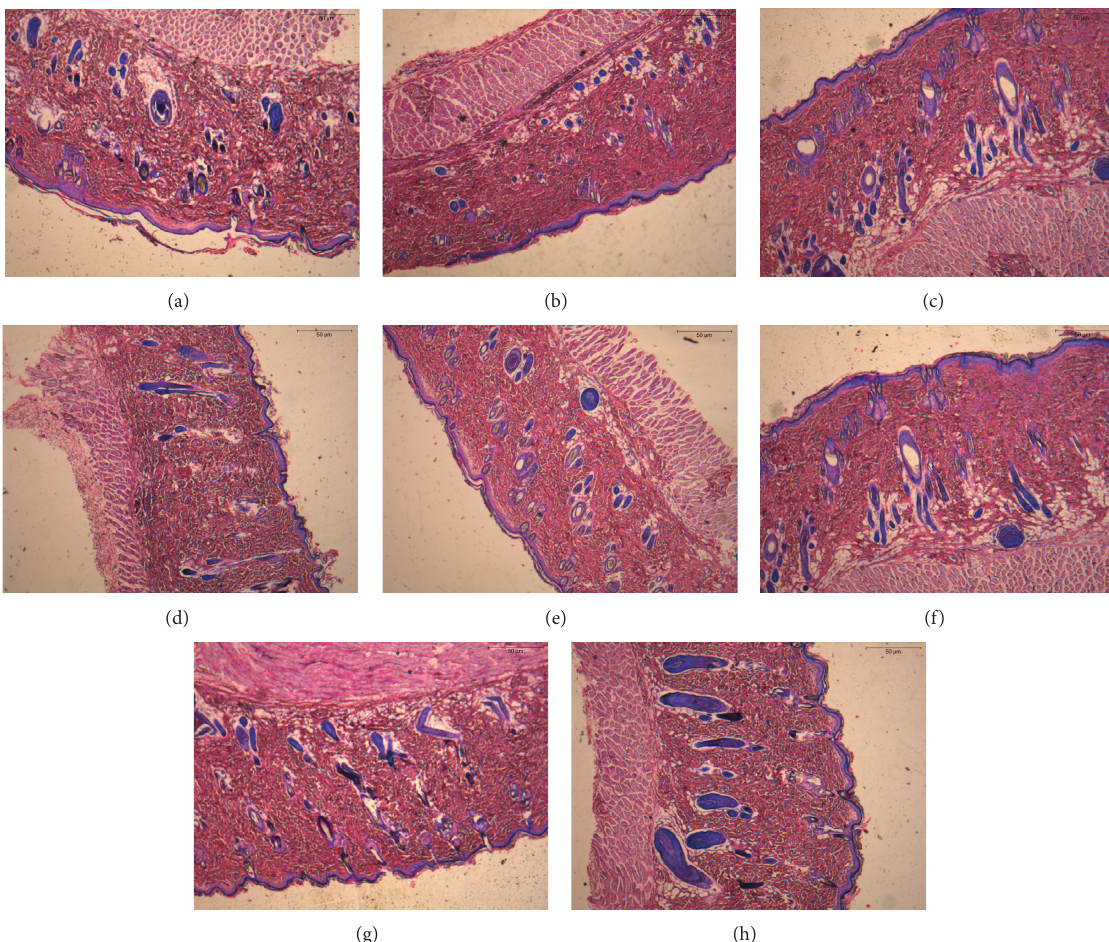
Figure 1: Histological appearance of skin wound from D-gal induced aging model of rats. Skin wounds were harvested for histology at 42 days after each treatment. Representative images of sections stained with H&E were presented at a low magnification (40x, scale bar = 50 𝜇 m). Letters (a) through (h) correspond to aging control, aging NS, aging AA, aging 0.1% DMAE, aging 0.2% DMAE, aging 0.1% DMAE + A, aging 0.2% DMAE + AA, and sham control,